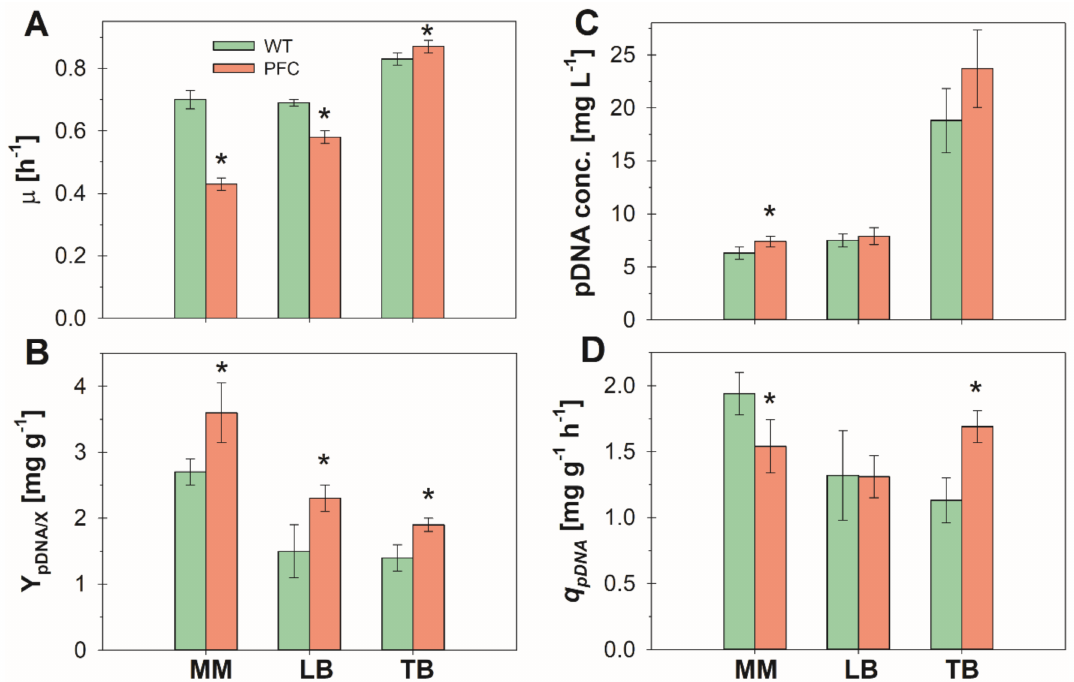
Figure 1. Main parameters of cultures of the wild type (green bars) and proteome reduced (PFC) (red bars) strains in mineral medium (MM), lysogeny (LB), and terrific (TB) broths. ( A ) Specific growth rate ( µ ) during the exponential growth phase. ( B ) Plasmid DNA (pDNA) yield on biomass (Y pDNA / X ) during the exponential growth phase. ( C ) pDNA concentration at the end of the cultures. ( D ) Specific pDNA production rate ( q pDNA ) during the exponential growth phase. Error bars show the standard deviation between triplicate experiments. * indicates the groups where significant di ff erence was found ( p <